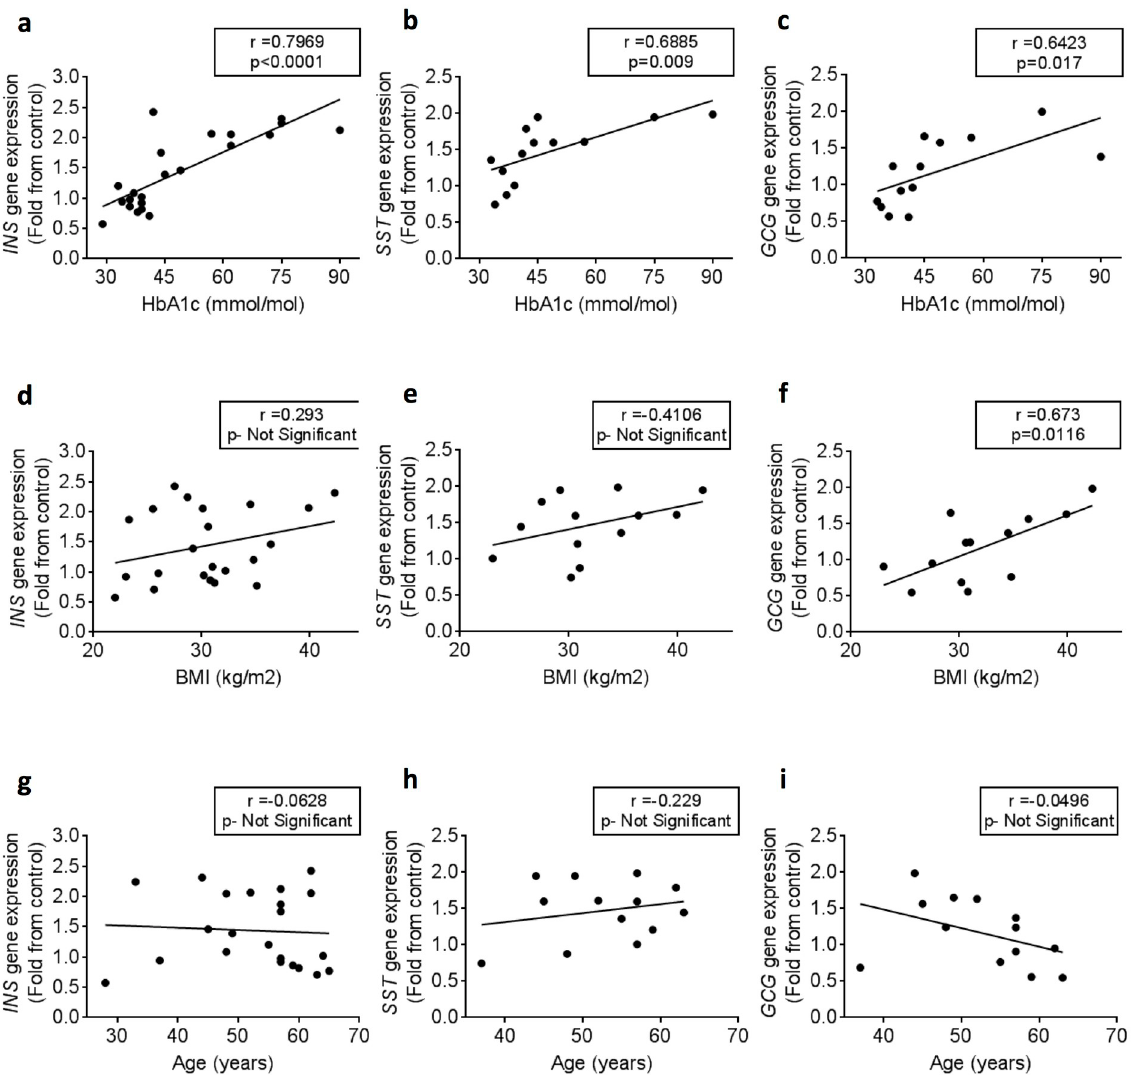
Fig 1. Correlation of donors HbA 1c levels with INS , SST and GCG genes fold change in response to gastrin treatment. Isolated human islets from a total of 13–22 independent donors were incubated with 0 nmol/l or 100 nmol/l gastrin for 48 h before qRT-PCR analysis a-c. Correlation of HbA 1c levels and INS , SST and GCG genes fold change in response to gastrin treatment. d-f. Correlation of donors BMI and INS , SST and GCG genes fold change in response to gastrin treatment. g-i. Correlation of donors age and INS , SST and GCG genes fold change in response to gastrin treatment. Pearson’s correlation test was used to determine correlation and significance.